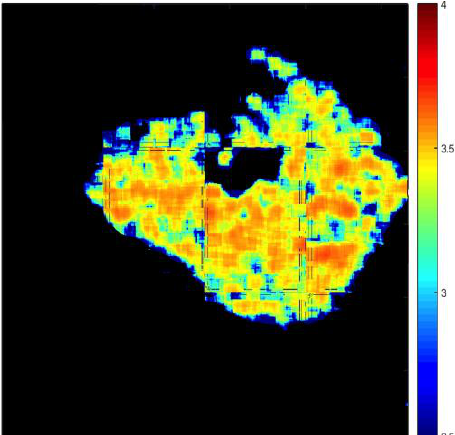
Figure 9. Age map of the floor of crater Tsiolkovsky using the CSFD obtained by the template matching method with an optimal threshold value in combination with the SCD algorithm without bins.